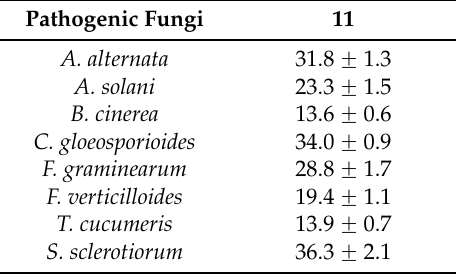
Table 3. Inhibitory activities of compound 11 against seven pathogenic fungi (EC 50 , µ